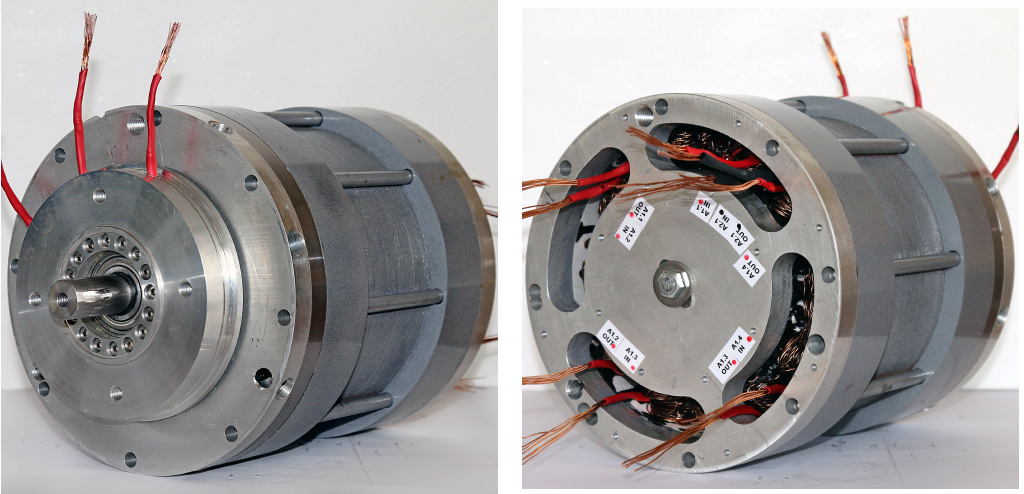
Figure 12. Front and rear view of SESM.